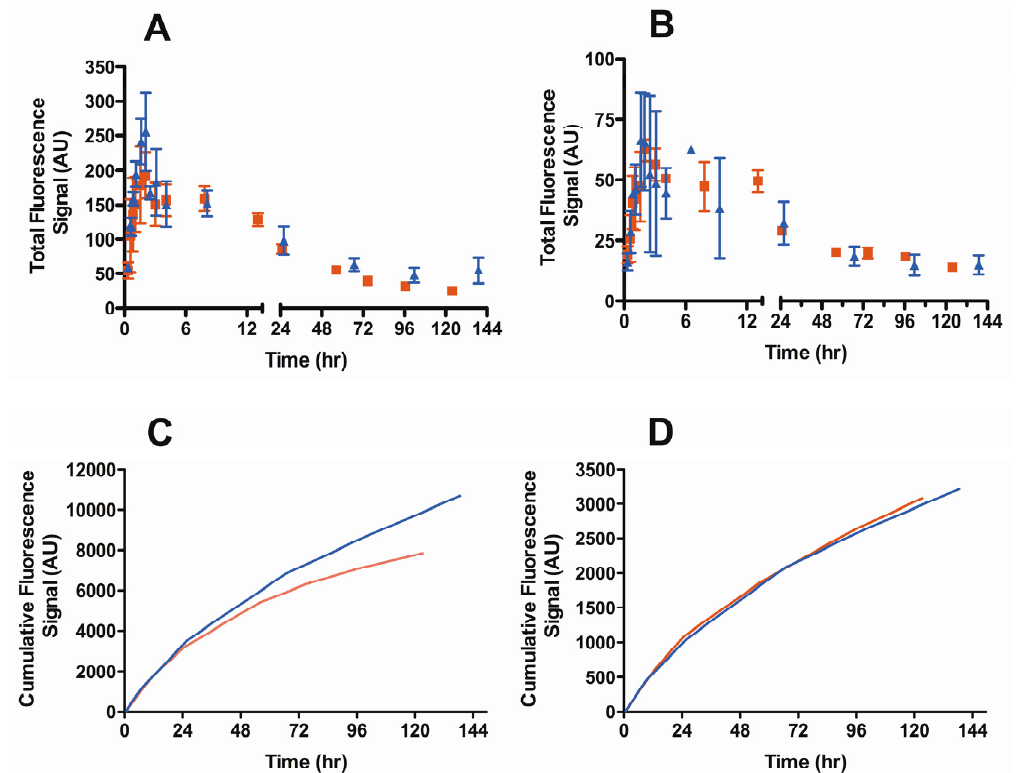
( A ) popliteal ( p = 0.032, student t -test) and ( B ) iliac lymph nodes ( p = 0.58, student t -test) in normal (triangles) and B16F10 tumor bearing mice (squares). Cumulative drainage of the 74-kDa HA-IR820 conjugate vs. time to the ( C ) popliteal (red line: with tumor; blue line: without tumor) and ( D ) iliac lymph nodes (red line: with tumor; blue line: without tumor) in normal and B16F10 tumor bearing mice.